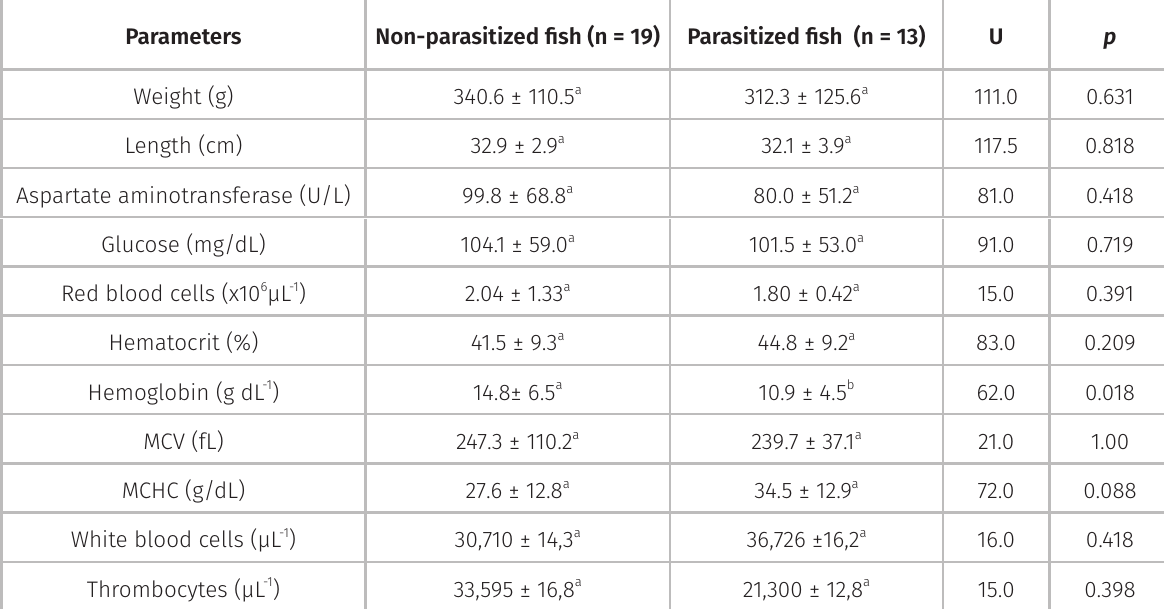
Table III. Body and blood parameters of Pterygoplichthys pardalis from the Tapajós River in eastern Amazon